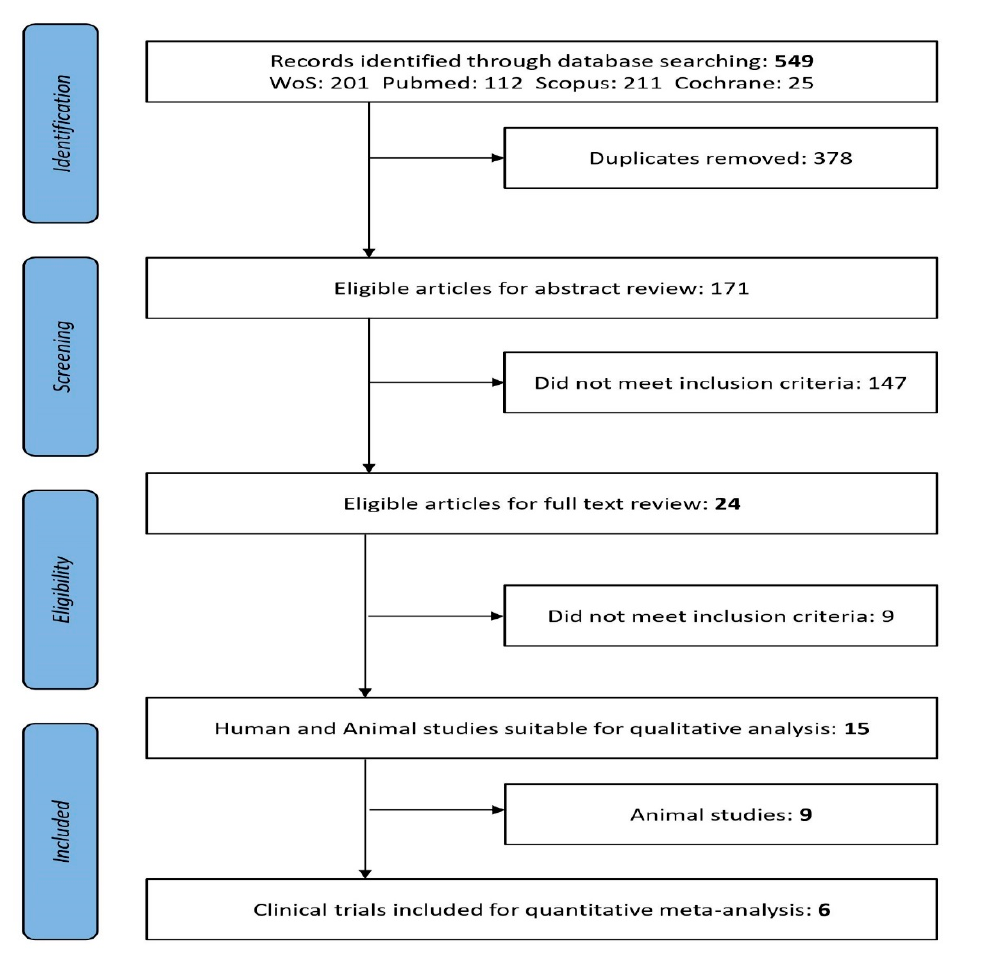
PRISMA flow diagram: Preferred Reporting Items for Systematic Reviews and Meta-Analyses [35].